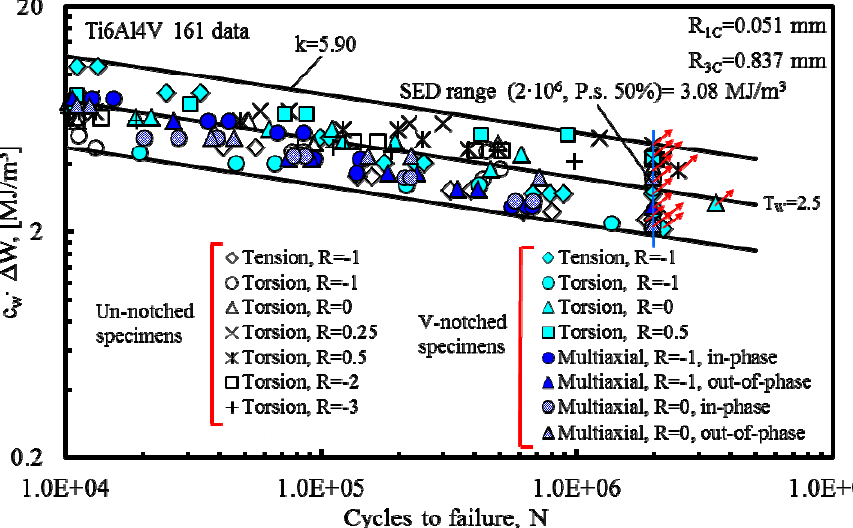
Figure 3: Synthesis by means of local SED of un-notched and V-notched specimens data.